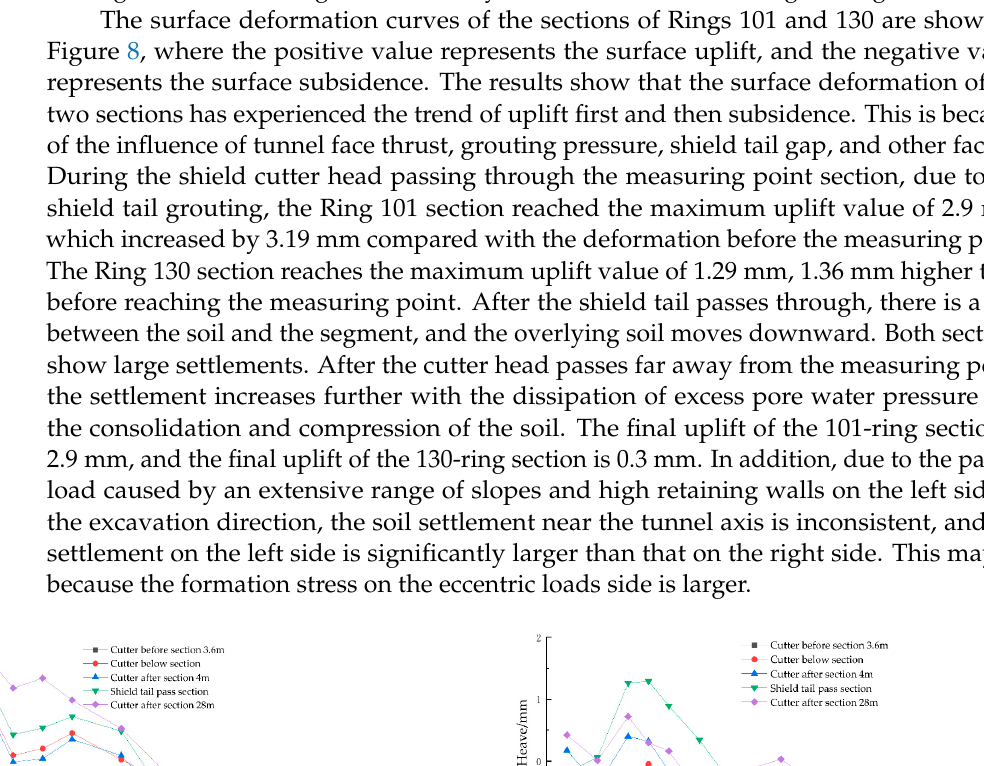
Figure 7. Main tunneling parameters of the monitoring section: ( a ) grouting pressure; ( b ) synchro- nous grouting volume; ( c ) speed of shield cutterhead; ( d ) torque of shield cutterhead; ( e ) gross thrust; ( f ) tunneling speed; ( g ) top pressure of slurry chamber.